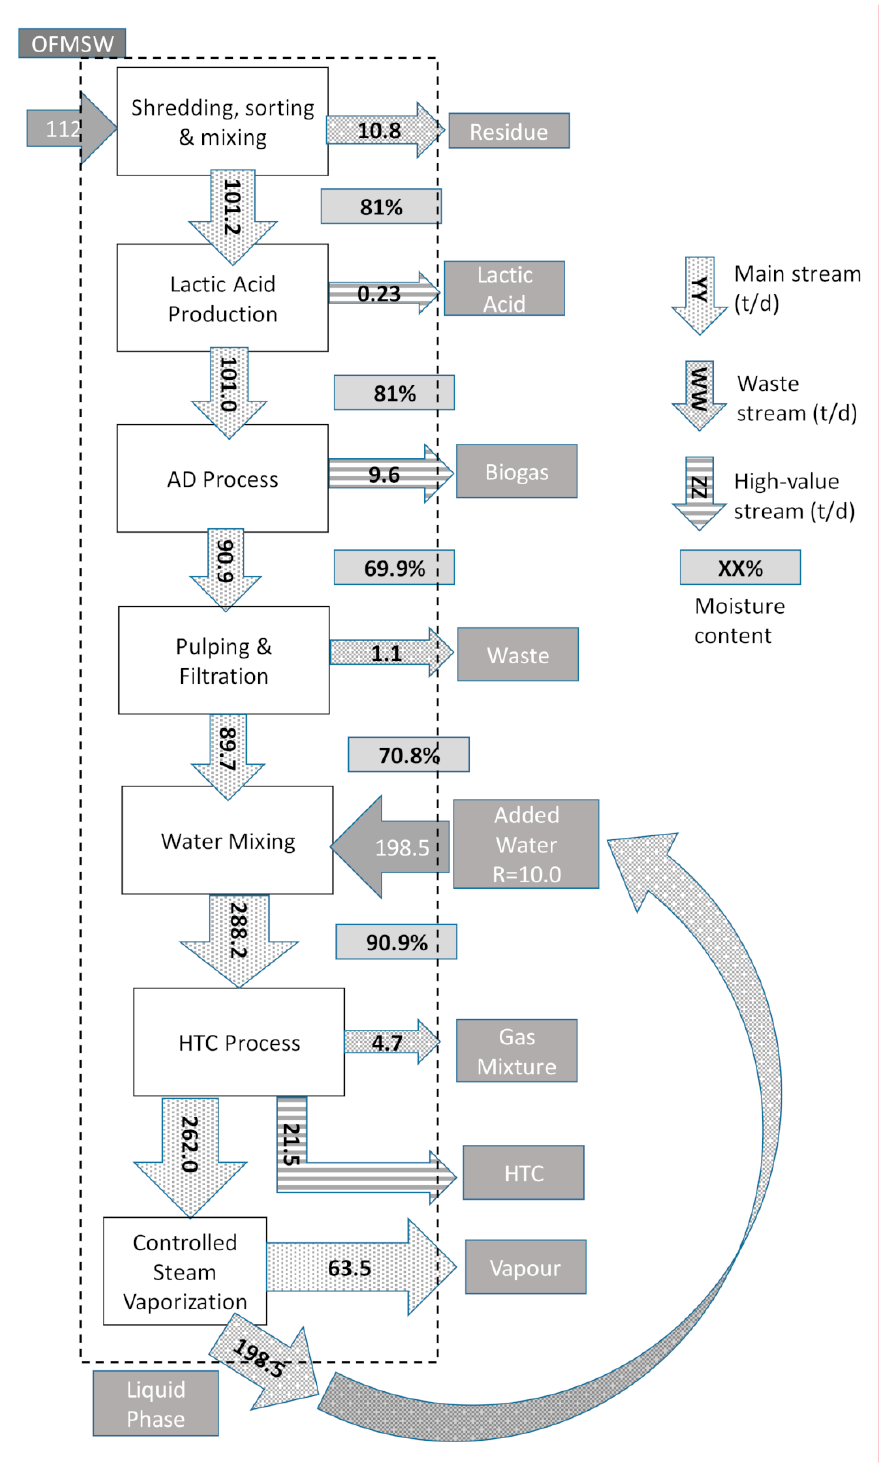
Figure 7. Integrated process stages and daily mass balance for R = 10.0 and T rxn = 250 ◦